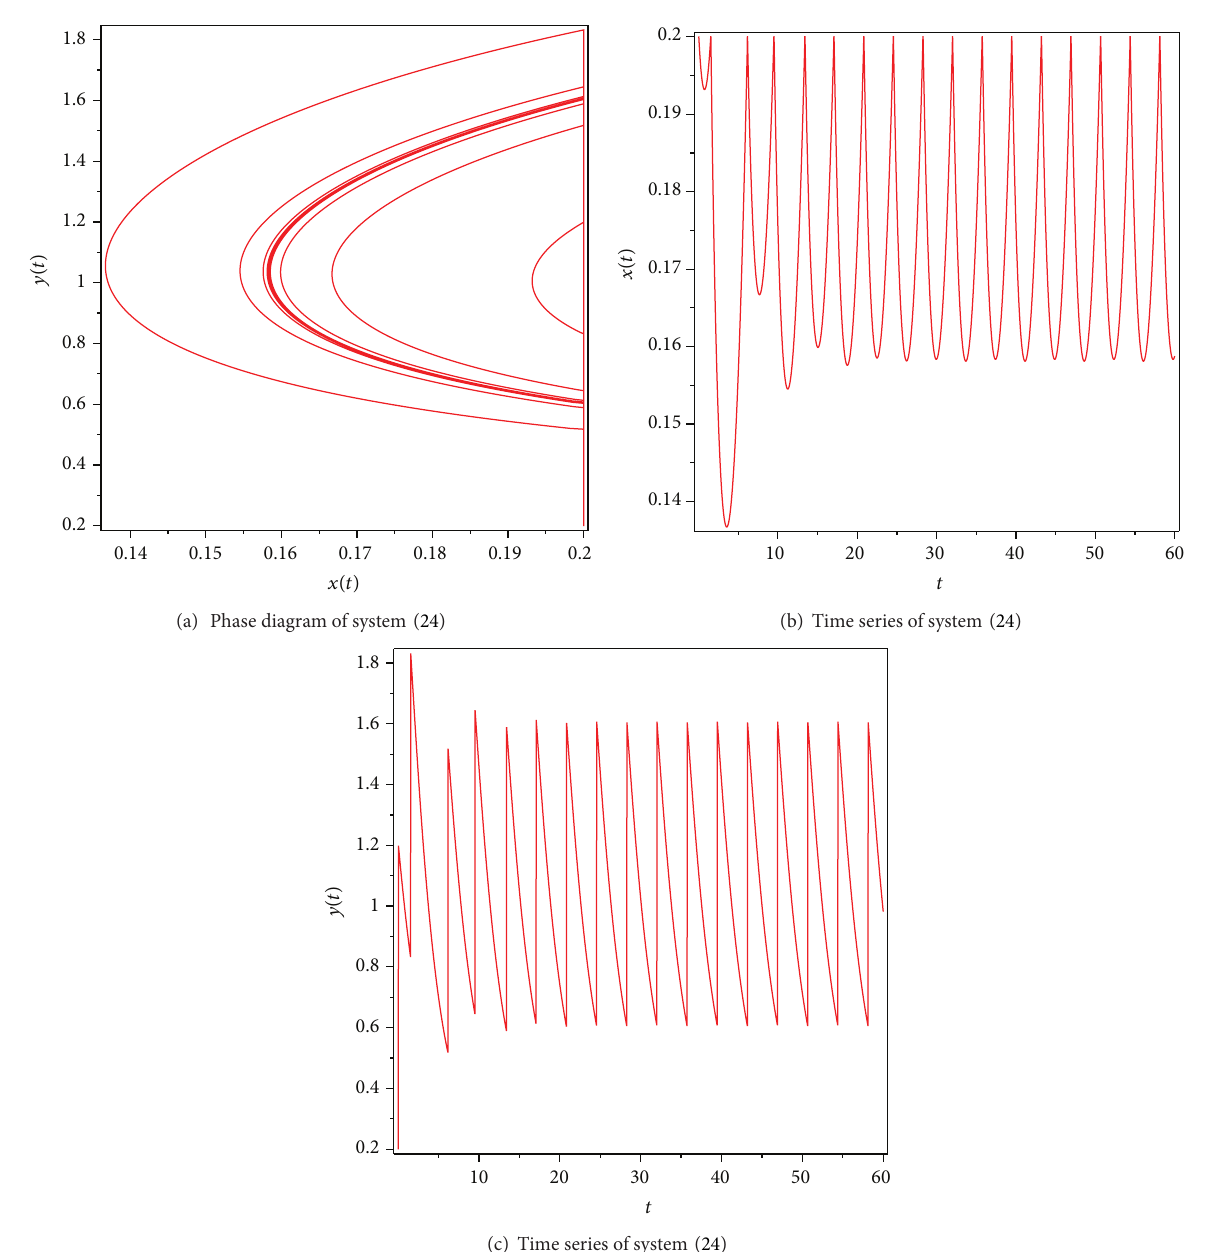
Figure 18: Illustration of basic behavior of system